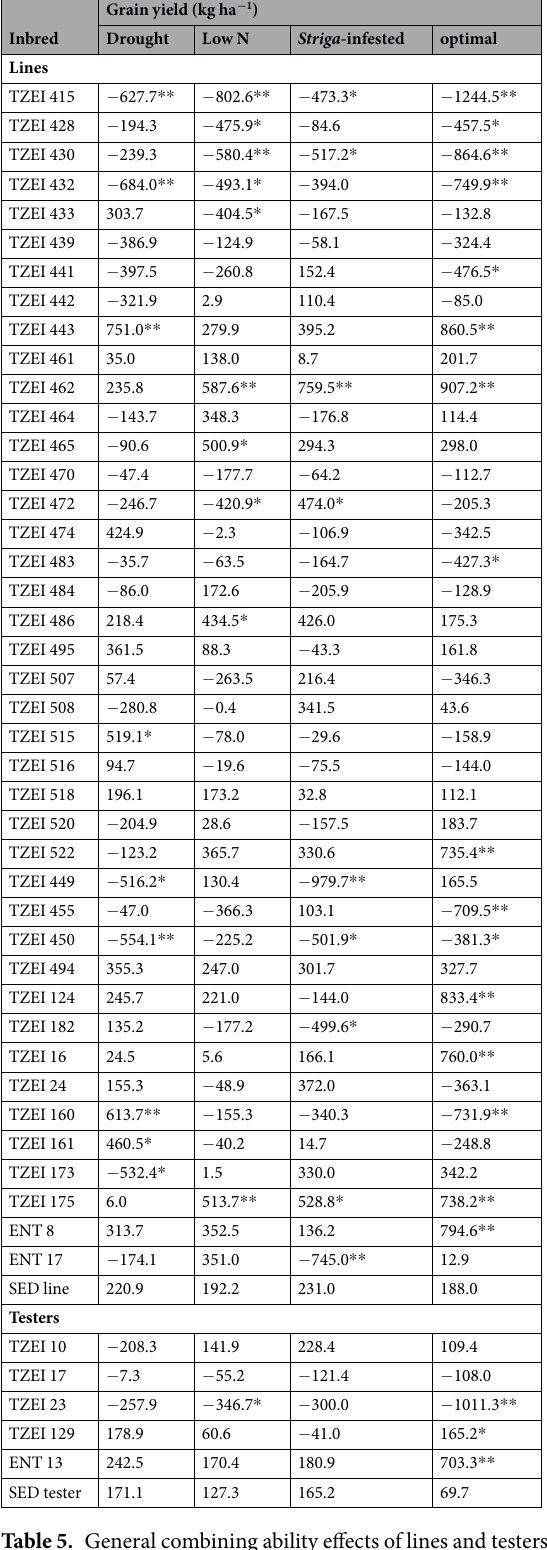
Table 5. General combining ability effects of lines and testers for grain yield under drought, Striga -infested, low N and optimal